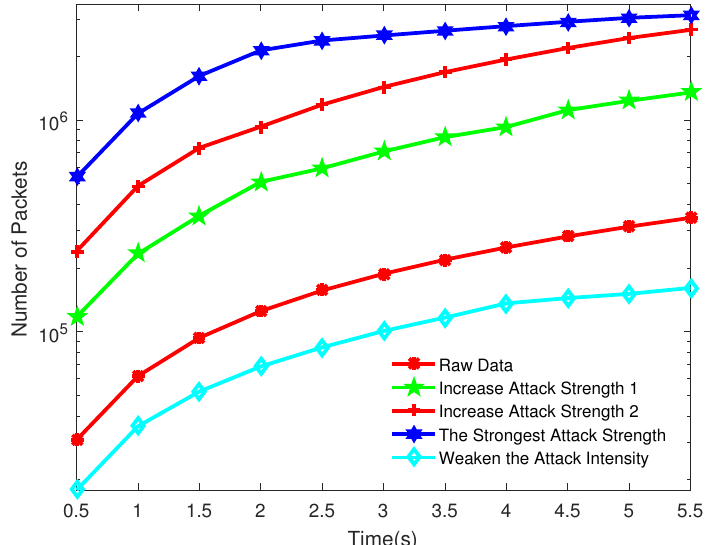
Figure 10. Frequency Diagram of Pseudo-IP Addresses.